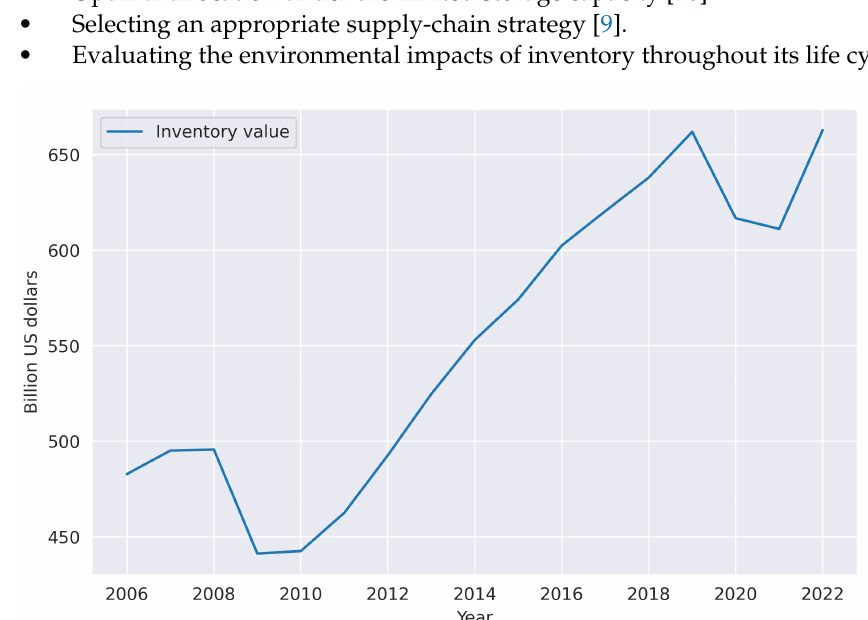
Figure 1. Value of inventories held for sale at the retail level. The figure was produced on the basis of data reported by the U.S. Census Bureau